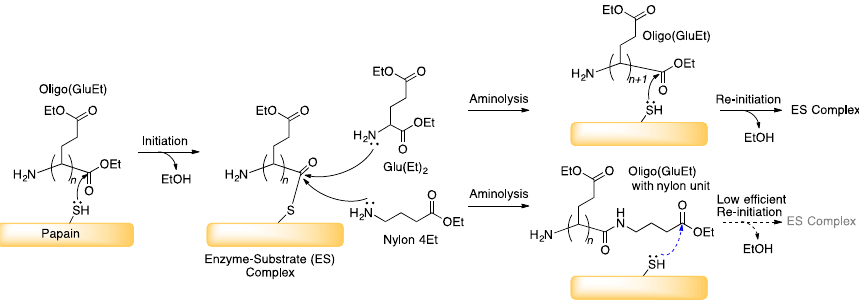
Scheme 1. Reaction scheme of the papain-catalyzed synthesis of peptides with a nylon unit.